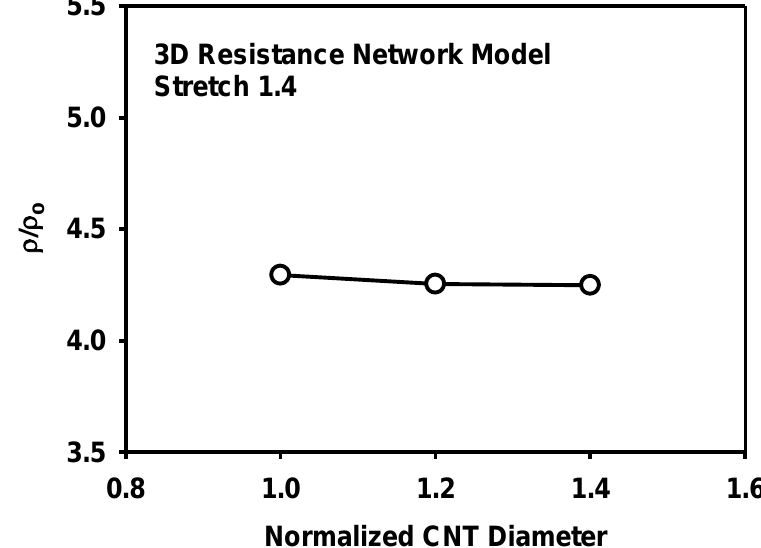
Figure 19. Effect of the CNT diameter on the resistivity as calculated by the 3D resistance network model.